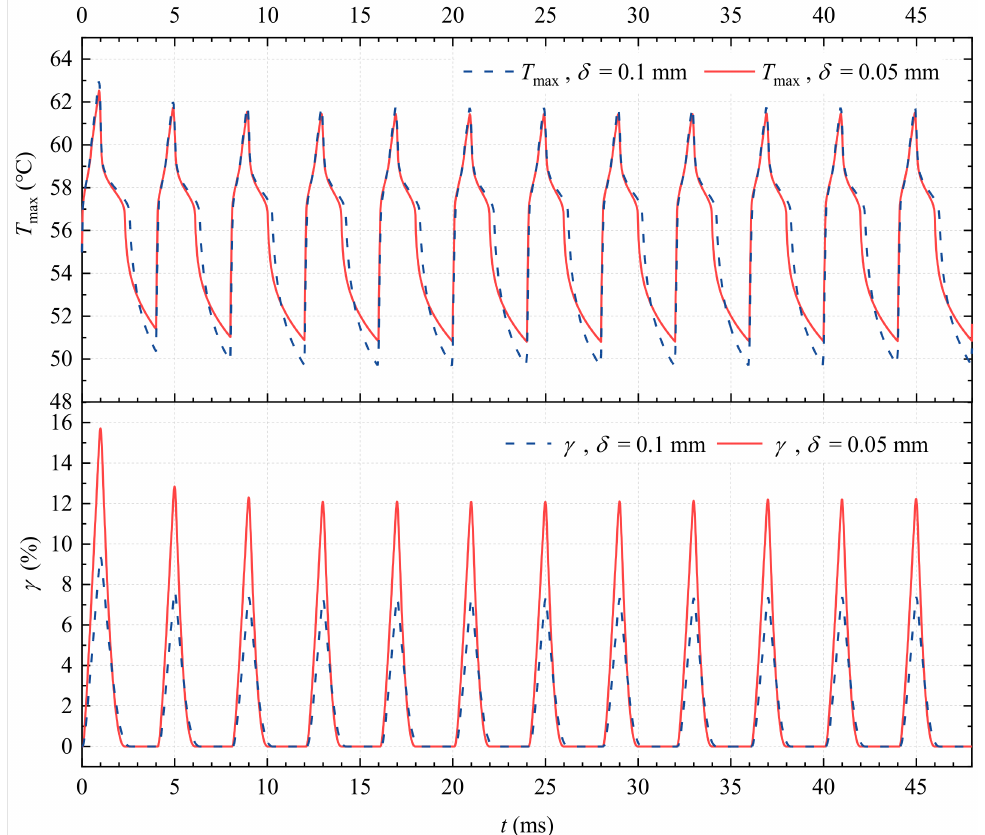
Figure 10. The variations in T max and γ with time when δ = 0.1 mm, 0.05 mm. Figure 11 shows the phase change process of the metallic PCM after reaching the periodic state when δ = 0.05 mm (corresponding to 44 ms~46.2 ms in Figure 10). The liquid fraction θ is 0 before the arrival of the heat pulse. During the heating period, the liquid fraction θ and phase change region increase rapidly, and then gradually decrease to 0 after the pulse. At the end of the heating period (45 ms), the phase change reaches its maximum, with a liquid fraction θ greater than 0.9 at the bottom and the thickness is about 0.005 mm. In the perpendicular direction, the phase change extends to 1/2 of the thickness, and the liquid fraction θ decreased with increasing thickness. It can also be seen that the phase change does not reach the periphery boundary even at the maximum γ , indicating that PCM with the same area of the heat source can work efficiently. The smaller melting area of PCM is due to the heat spreading from the heat source to the base of the heat sink, causing a lower heat flux and temperature in the marginal